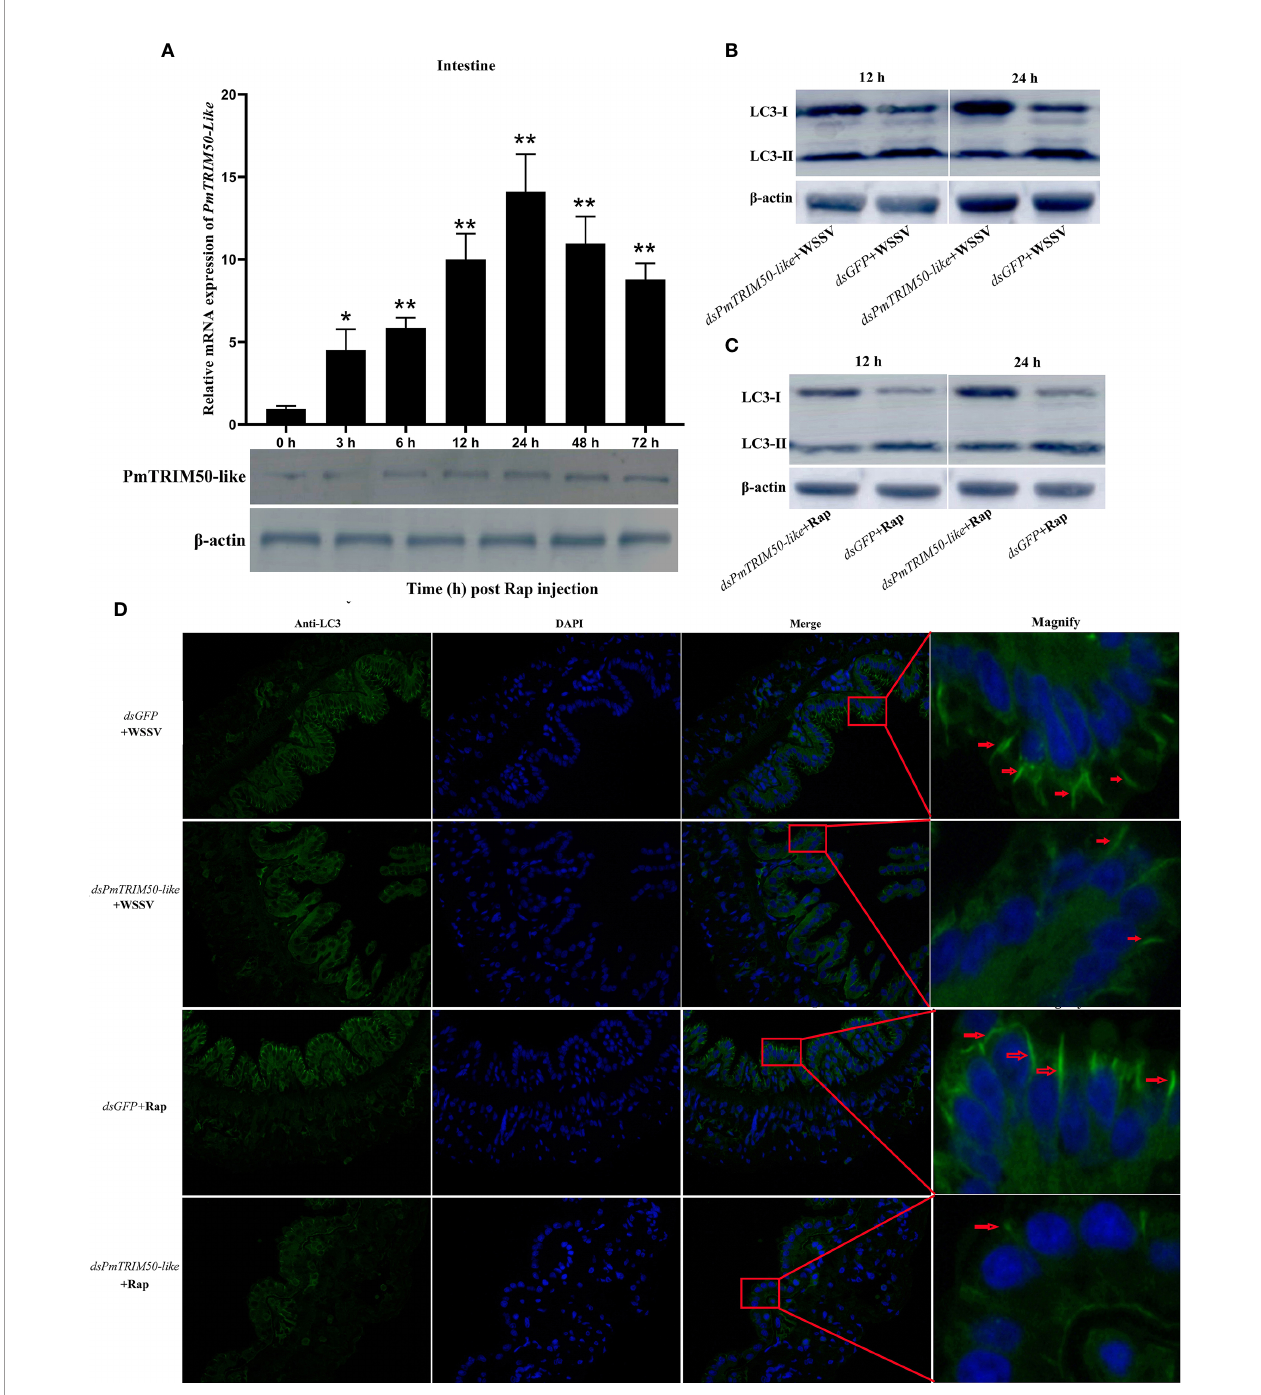
FIGURE 4 | PmTRIM50-like was required for autophagy in shrimp. (A) Expression patterns of PmTRIM50-like mRNA and protein were detected by qRT-PCR (upper panel) and western blotting (lower panel) in the intestine after rapamycin challenge. b -actin was used as an internal reference. (B) The expression of LC3-II/ LC3-I in dsPmTRIM50-like +WSSV and dsGFP +WSSV groups was detected by western blotting. (C) The expression of LC3-II/LC3-I in dsPmTRIM50-like +Rap and dsGFP +Rap groups was detected by western blotting. (D) The distribution of the autophagy marker LC3 in dsPmTRIM50-like +WSSV, dsGFP +WSSV, dsPmTRIM50-like +Rap, and dsGFP +Rap groups was detected by immunocytochemistry. Positive immunoreactivities of LC3 are indicated by red arrows. Asterisks indicate signi fi cant differences (* P<0.05 and ** P<0.01 ) compared with values in the control group. Error bars represent mean ± S.D. of three independent PCR ampli fi cations and quanti fi